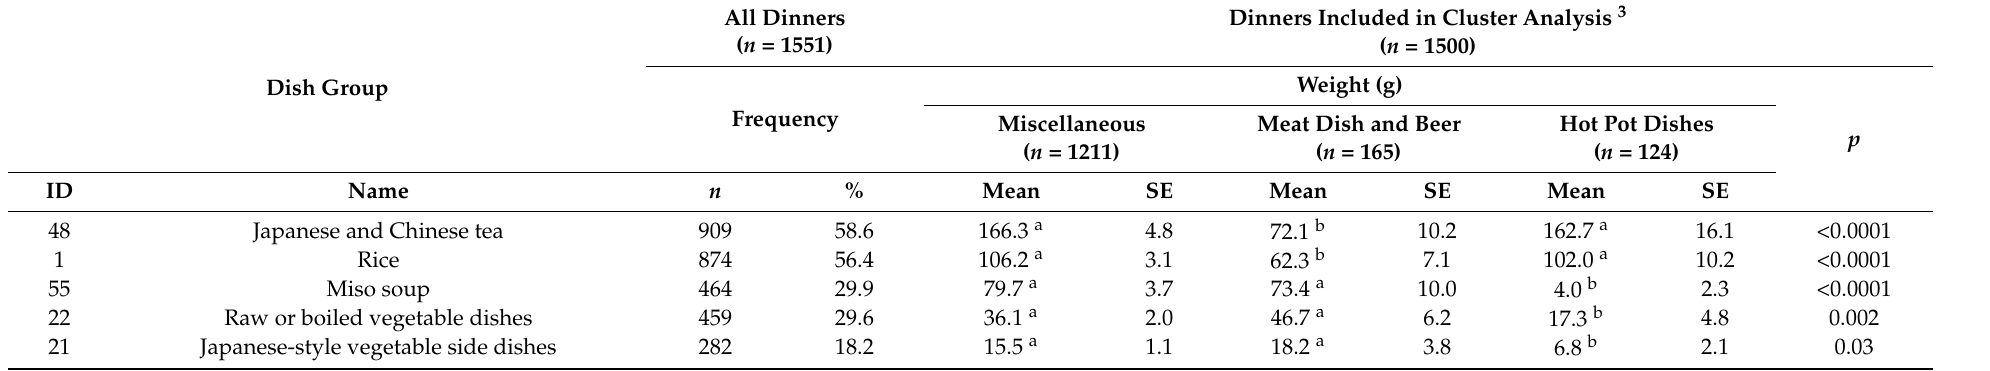
Table 3. Consumption frequency of dish groups in all dinners 1 and weight (g) of dish groups in each dietary pattern 2